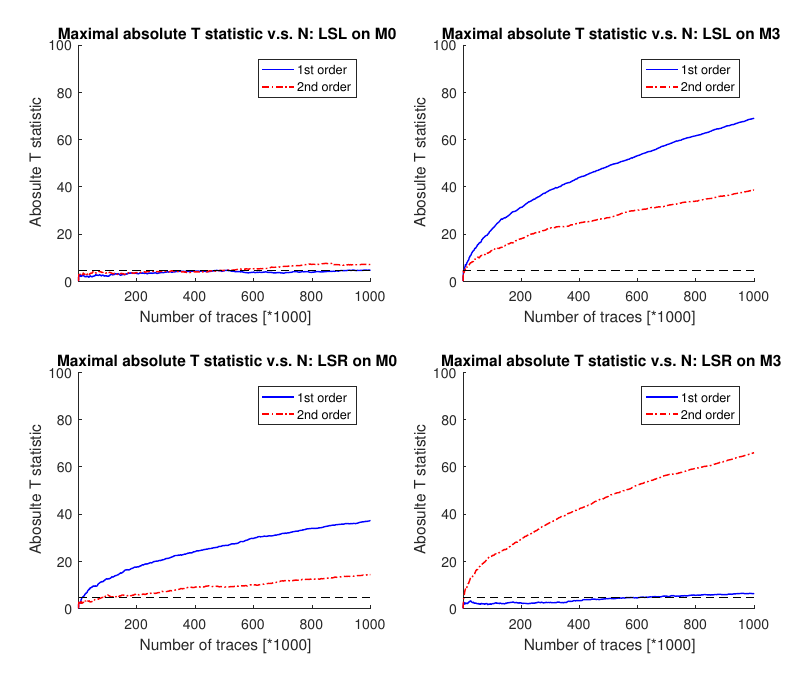
Figure 6: Instruction-wise leakage analysis: